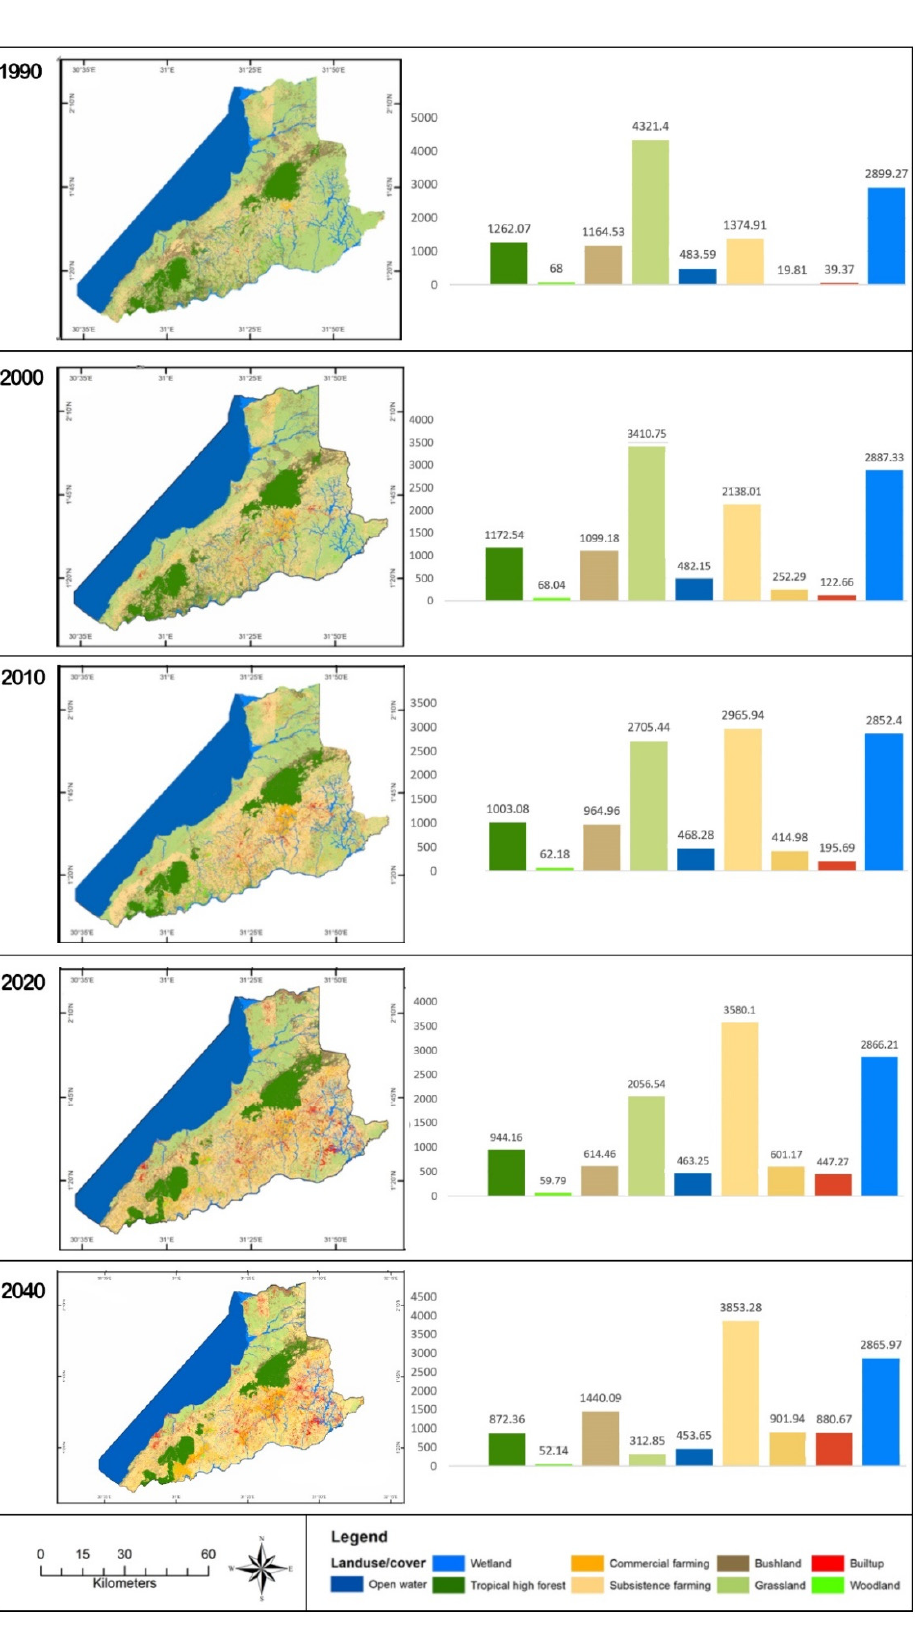
Figure A1. LULCC in the Budongo–Bugoma landscape using Landsat satellite imagery of single path and row